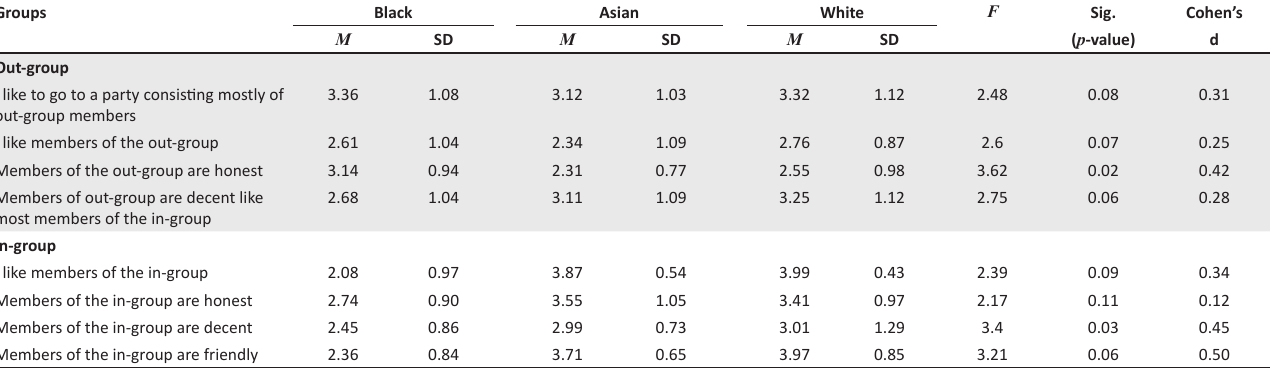
TABLE 4: Ethnic group differences for attitudes towards in-group and out-group members.